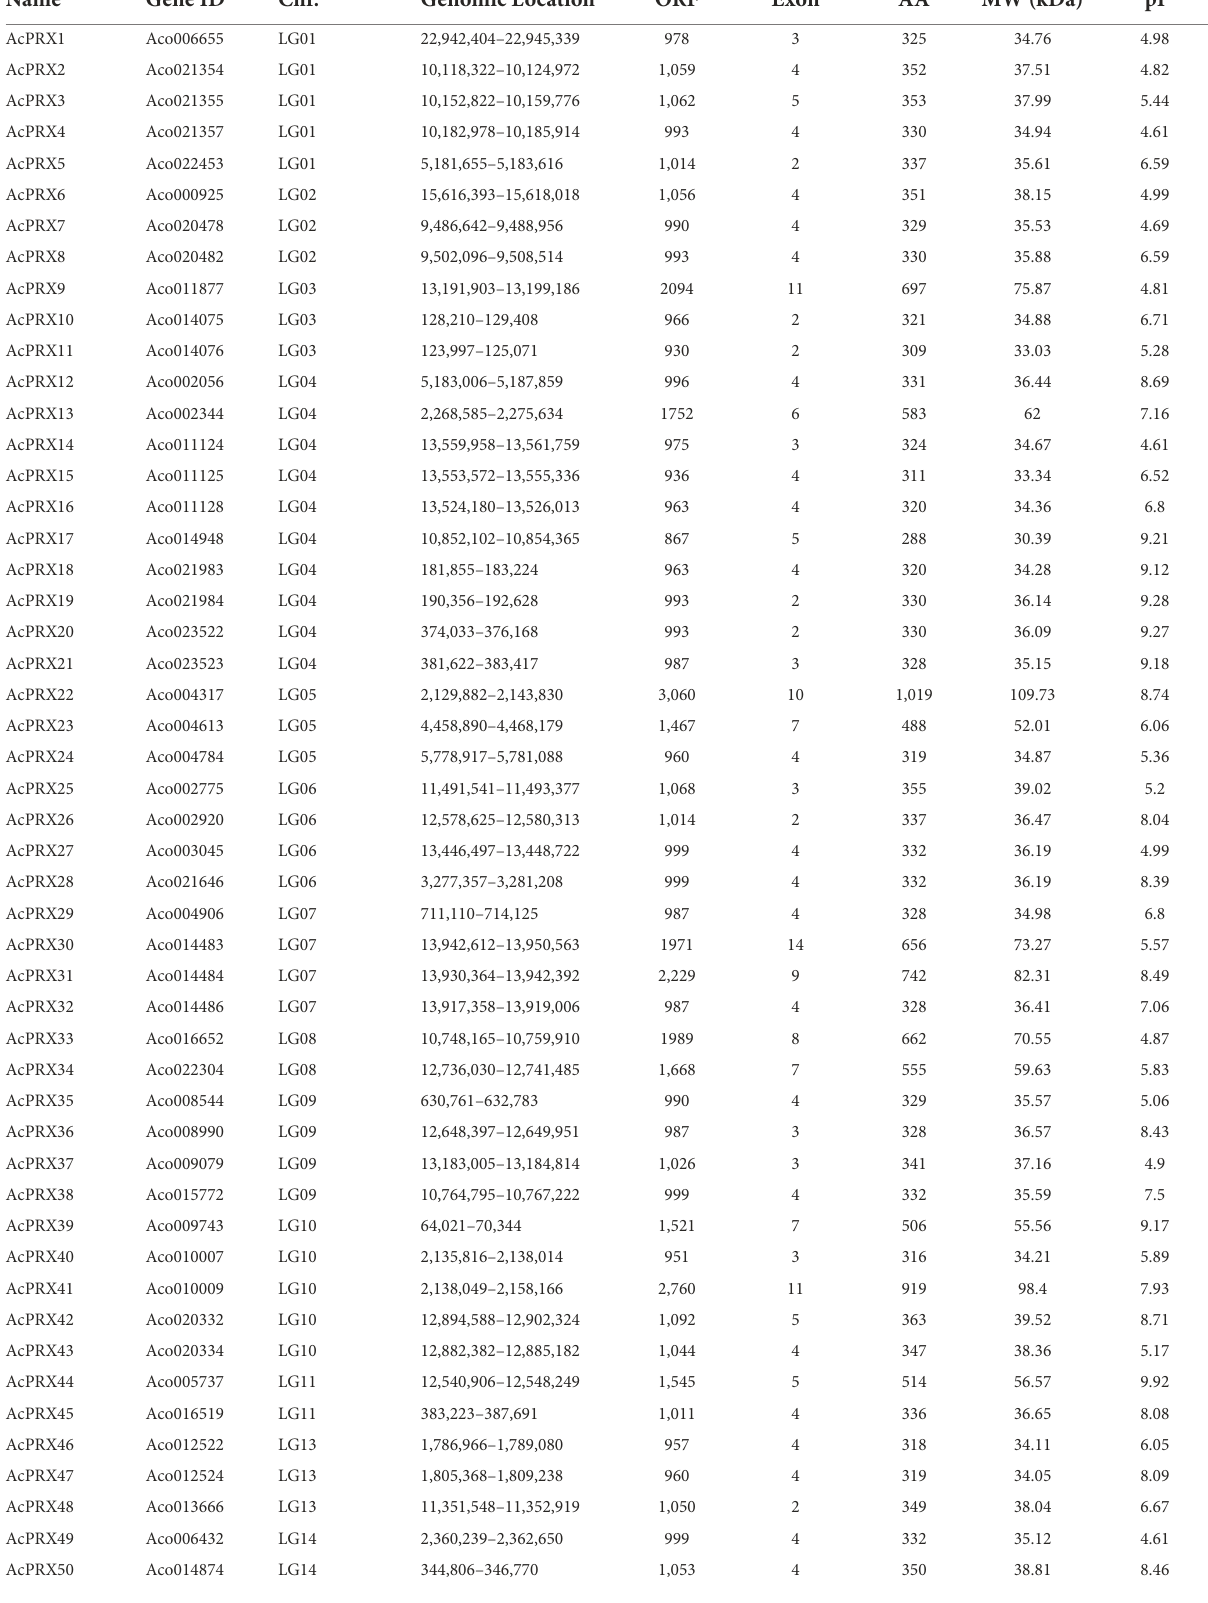
TABLE 1 Characteristics of AcPRXs confirmed in